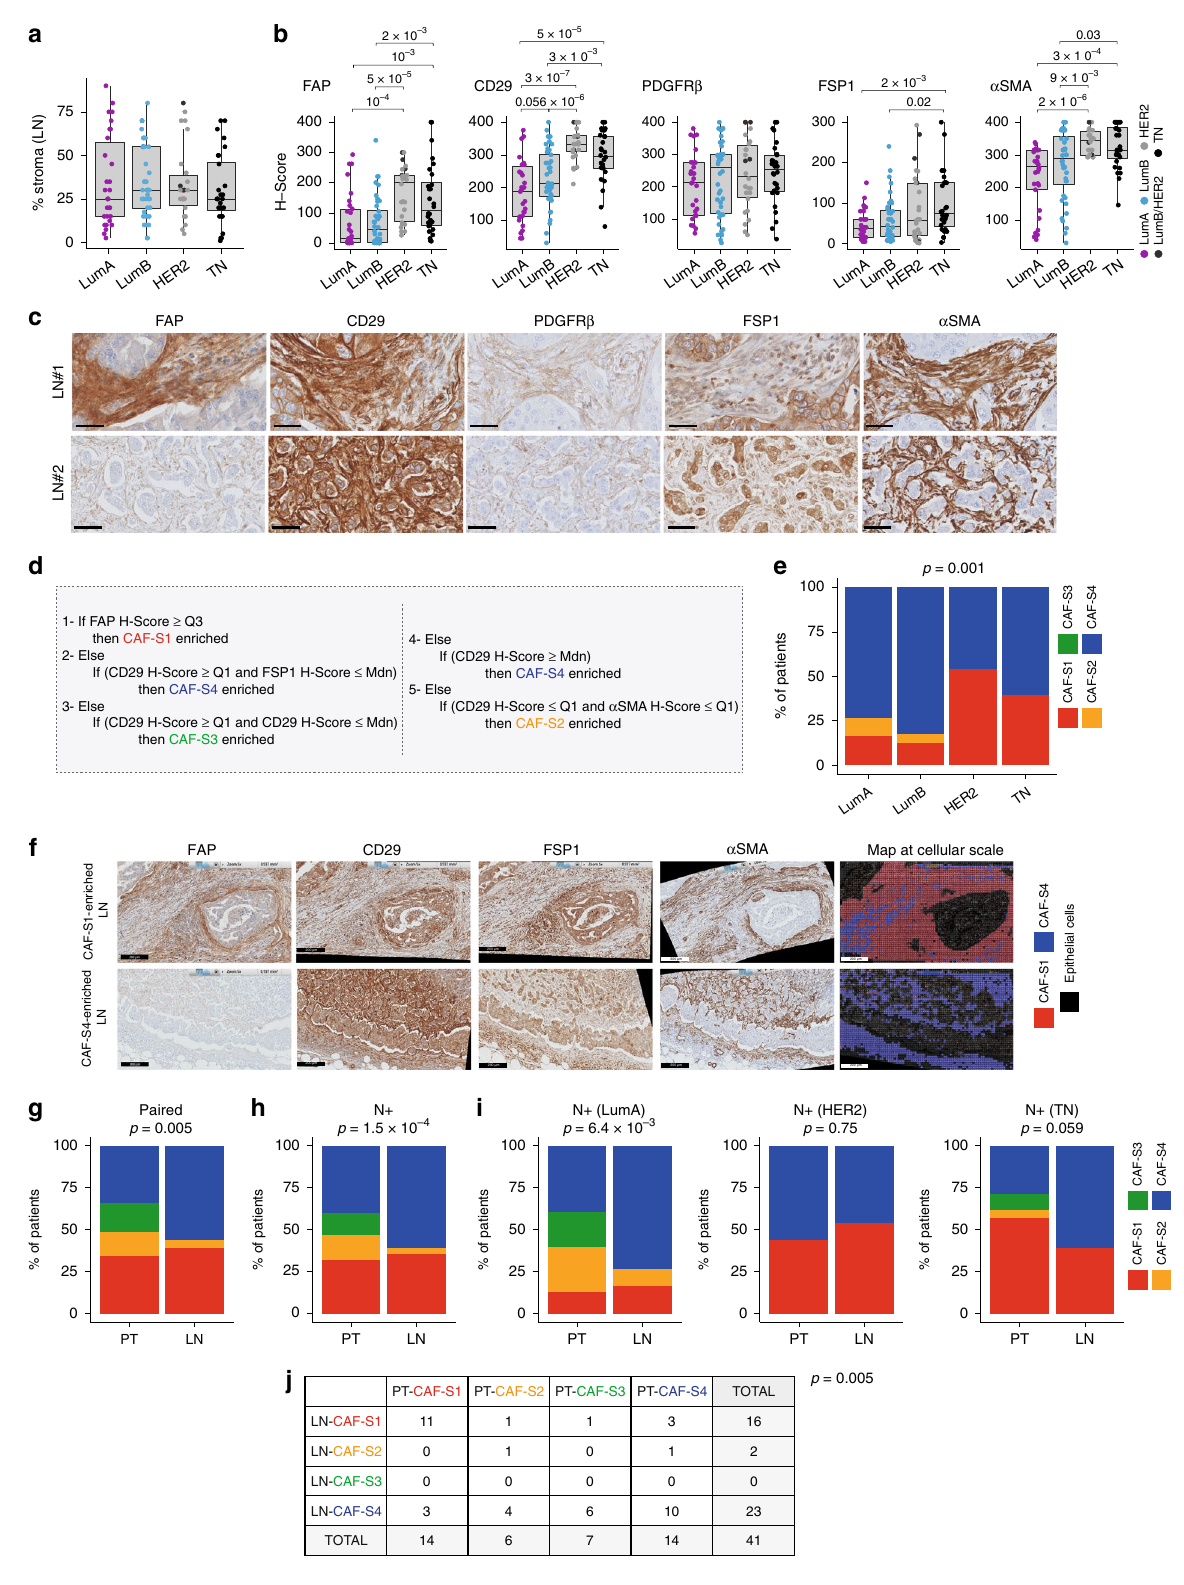
spheroids made by CAF-S4 pulled more ef fi ciently on collagen Supplementary Fig. 3f, h). Moreover, the strain energy (that fi bers than CAF-S1 (Fig. 4e). To further quantify the traction measures the energy spent to deform the substrate) developed by forces exerted by CAF on matrix, we performed traction force CAF-S4 was more than twofold higher than that of CAF-S1 microscopy (TFM). We observed that CAF-S1 were more elon- (Supplementary Fig. 3g). To take into account differences in gated compared to CAF-S4 that were larger (Fig. 4f and surface area between CAF-S1 and CAF-S4 (Supplementary NATURE COMMUNICATIONS| (2020) 11:404